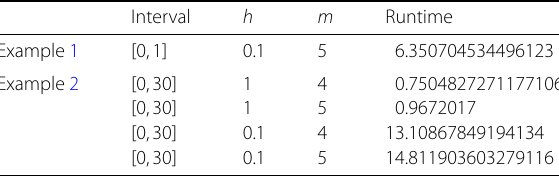
Interval h m Runtime Example